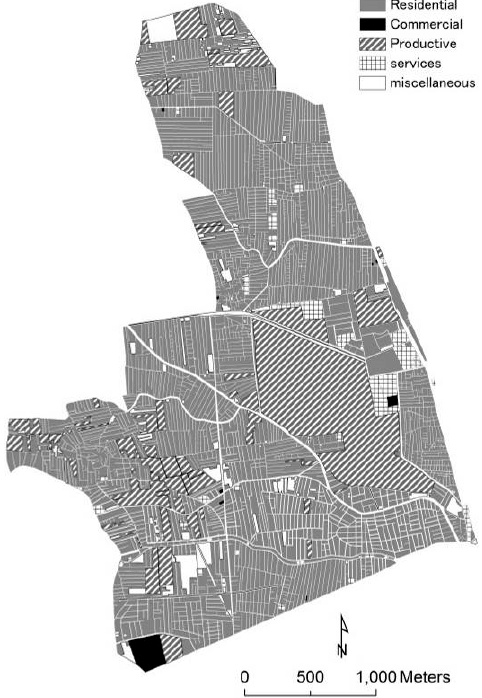
Figure 4. Shows land-use in